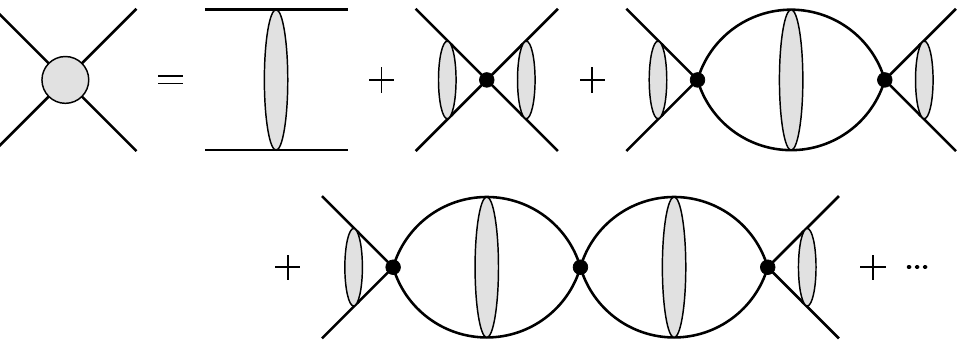
Figure 15 . Diagrams for the transition amplitudes A ij ( E ) expressed as a sum over the number of zero-range interactions. A solid line represents either a neutral wino or a charged wino. The bubble diagrams must be summed to all orders. Each bubble is summed over a neutral-wino pair w 0 w 0 and a charged-wino pair w + w (cid:0) . On the right side of the equation, a shaded blob represents Coulomb